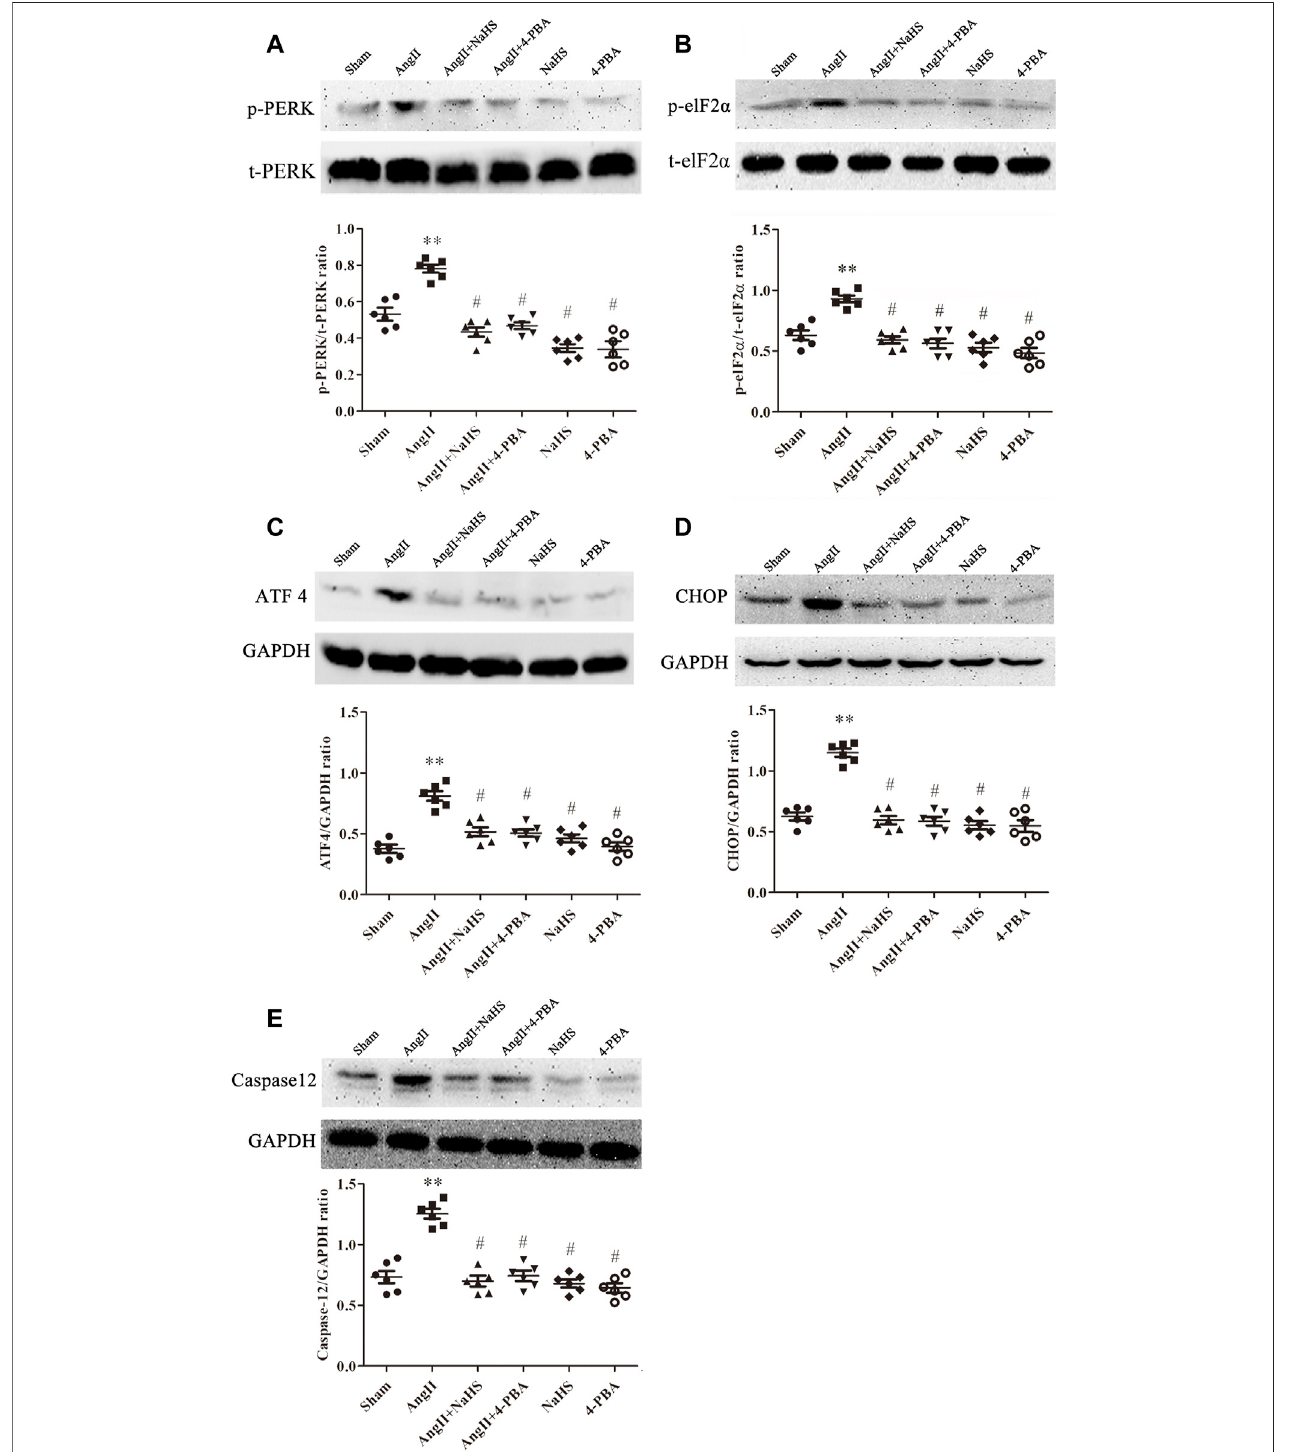
FIGURE3| NaHSattenuated theERSintheleftatriumgainedfromratsunderAngIItreatment.RepresentativeWesternblottingandrelativedensitometryanalysis of (A) p-PERKwitht-PERKastheloadingcontrol, (B) p-elF2 α witht-elF2 α astheloadingcontroland (C) ATF4, (D) CHOPand (E) caspase12withGAPDHastheloading controlintheratsleftatrial tissueoftheindicatedgroups. ( n (cid:1) 6ineach group) **p < 0.01VSSham, #p < 0.01VSAngII. Groupswerecompared using one-wayanalysis of variance (ANOVA) (Tukey ’ s) in (A – E) .